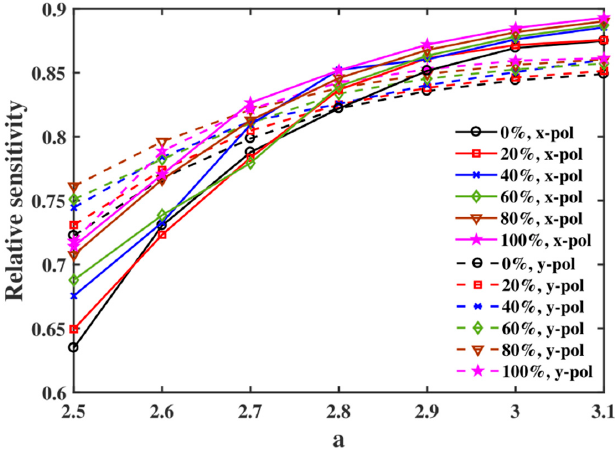
Figure 4. Relative sensitivity of the proposed sensor as a function of ( a ) ( L/W ) at 2.8 THz.